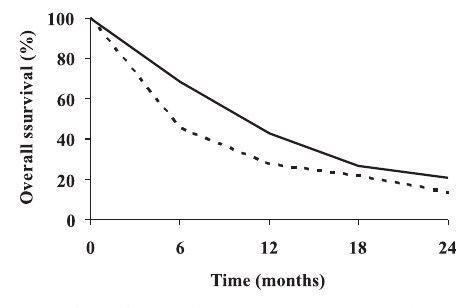
Figure 2 – Overall survival according to treatment of metastatic NSCLC patients (p<0.001 log-rank and Breslow).